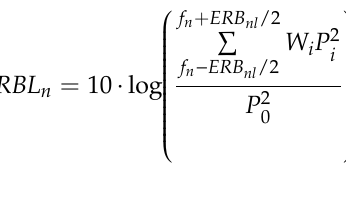
Figure A1. The cochlea in the inner ear can be assumed as an array of bandpass auditory filters with overlapping passbands. The length of each auditory filter is calculated